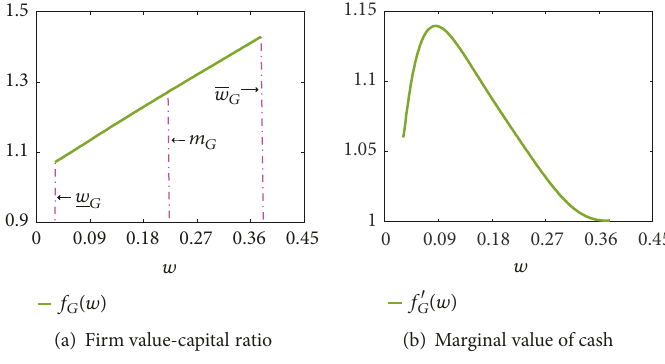
Figure 2: Firm value-capital ratio and its sensitivity in state 𝐺